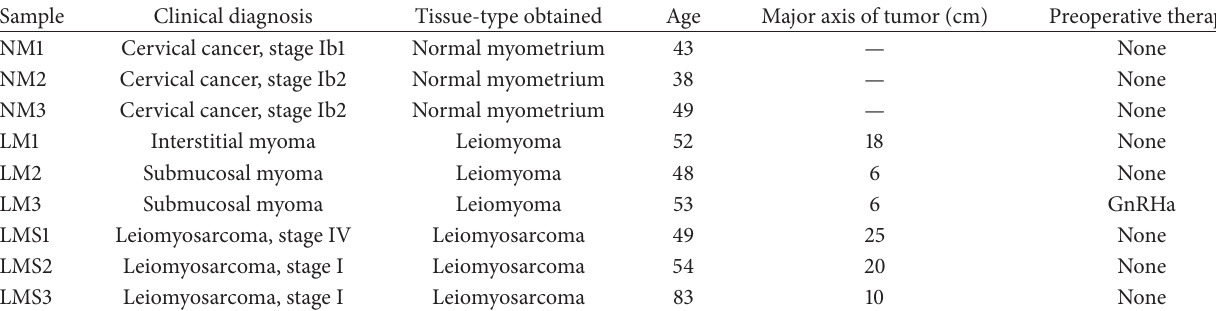
Table 1: Clinical features of nine samples analyzed in this